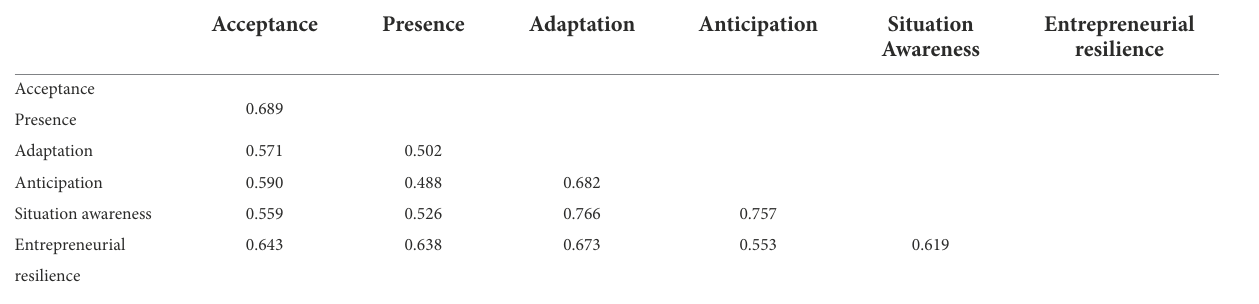
TABLE 5 The heterotrait-monotrait ratio of correlations.